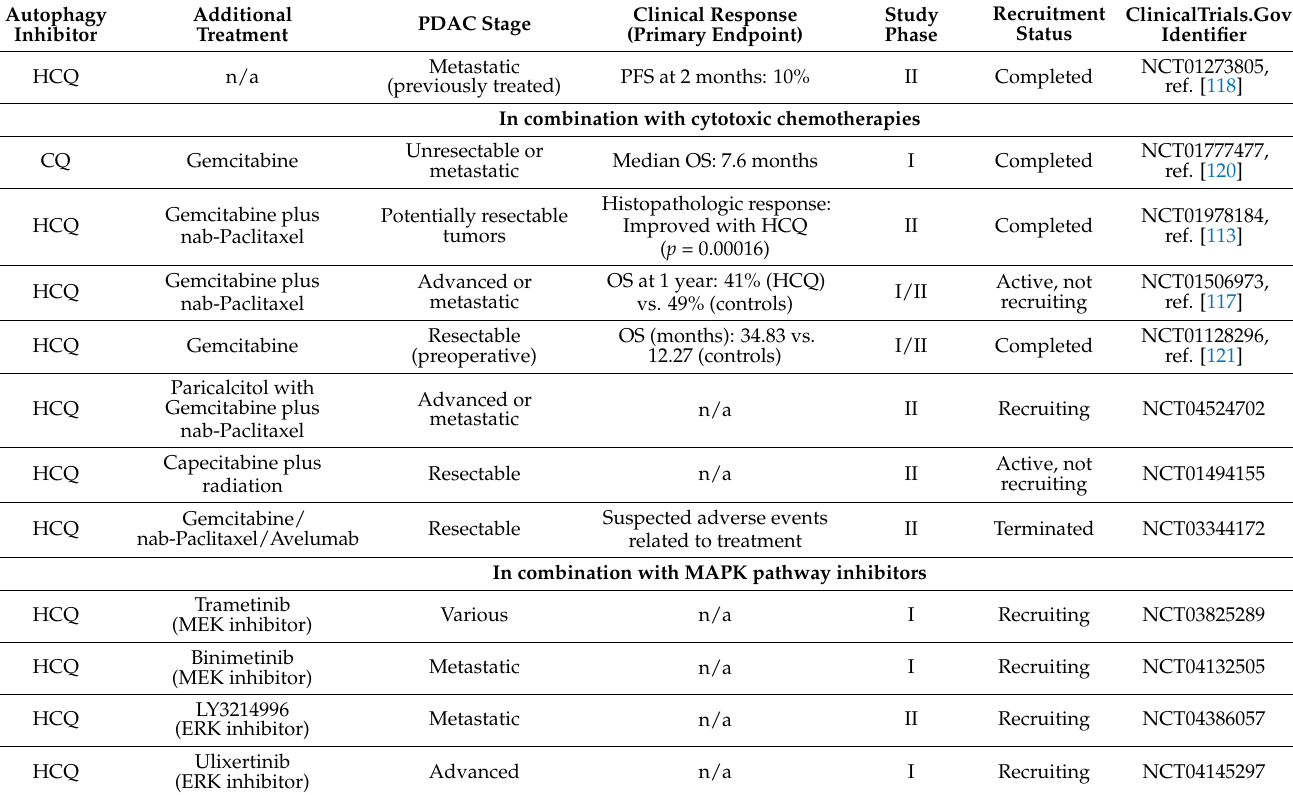
Table 1. Clinical trials targeting autophagy in pancreatic